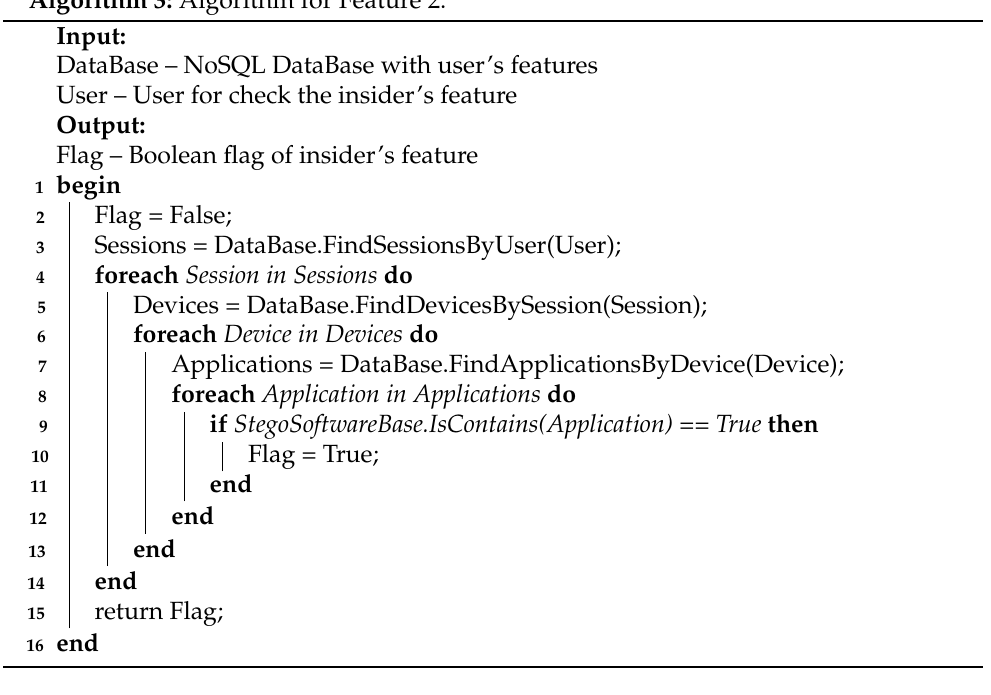
Algorithm 3: Algorithm for Feature 2.